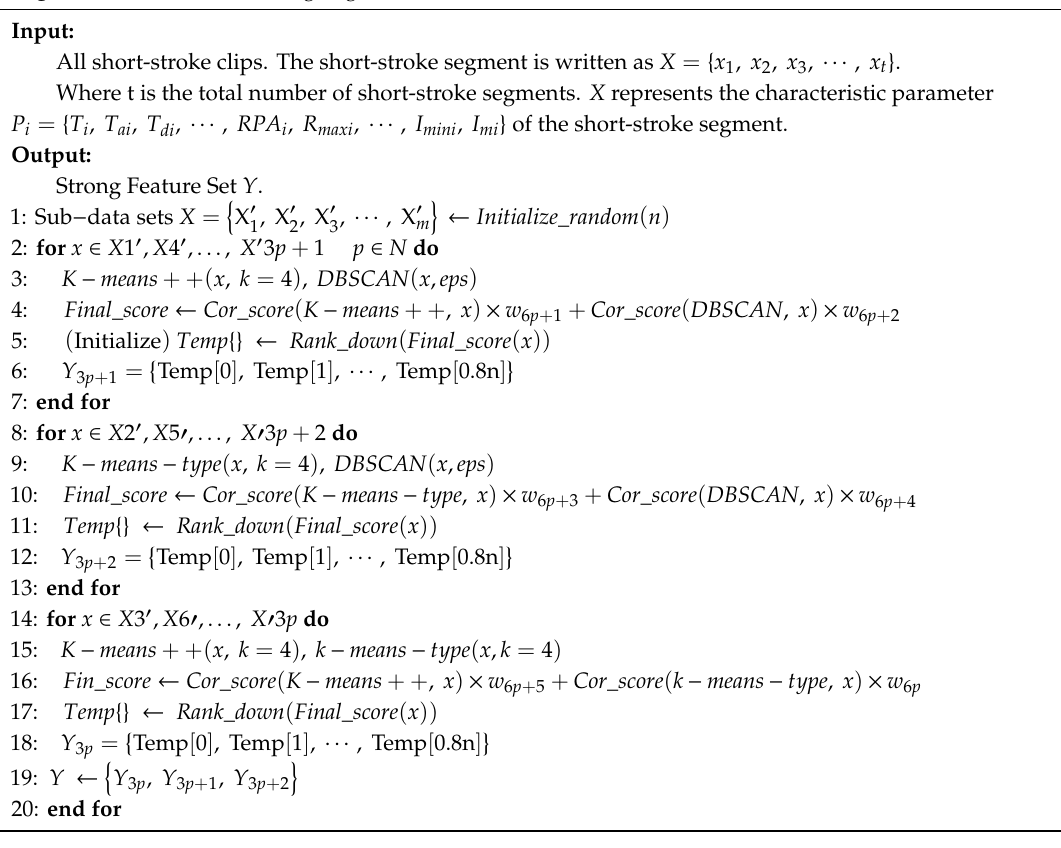
Algorithm 1: Multi-Clustering Algorithm